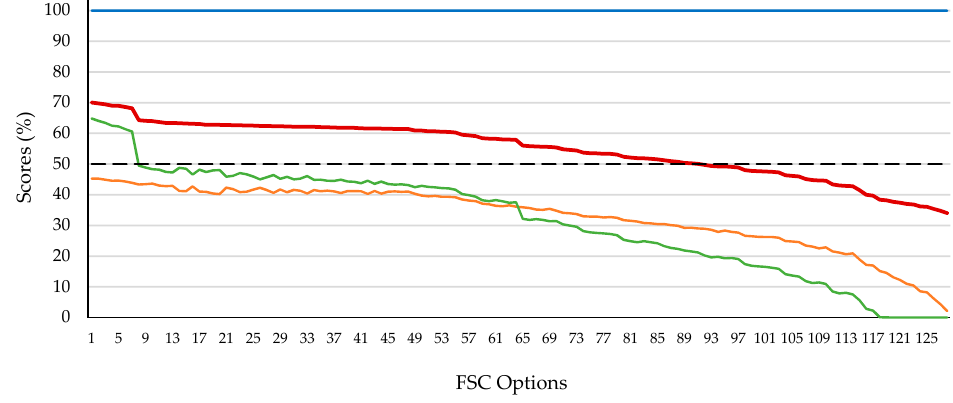
Figure 18. Graphical presentation of all FSCs that satisfy the load demand at 57.7 kWh/day.